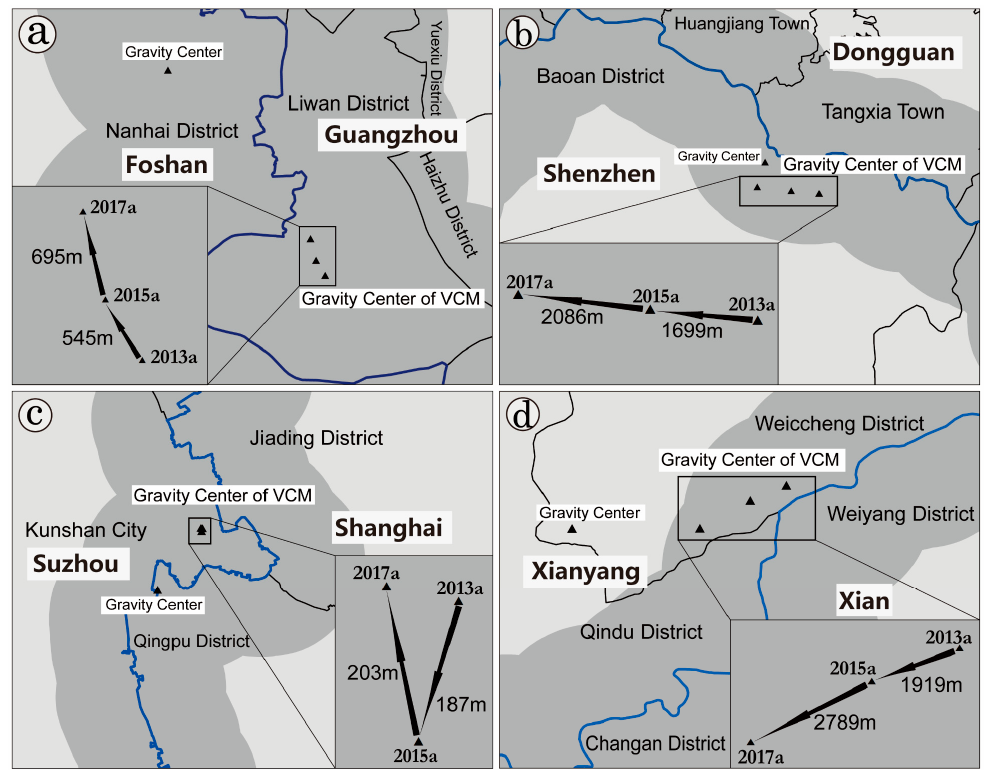
Figure 4. The nighttime light gravity center shift trajectories of integrated cities in 2013, 2015, and 2017. Note: the light gravity center shift trajectory is listed as: ( a ) Guangfo; ( b ) Guanshen; ( c ) Husu and ( d )